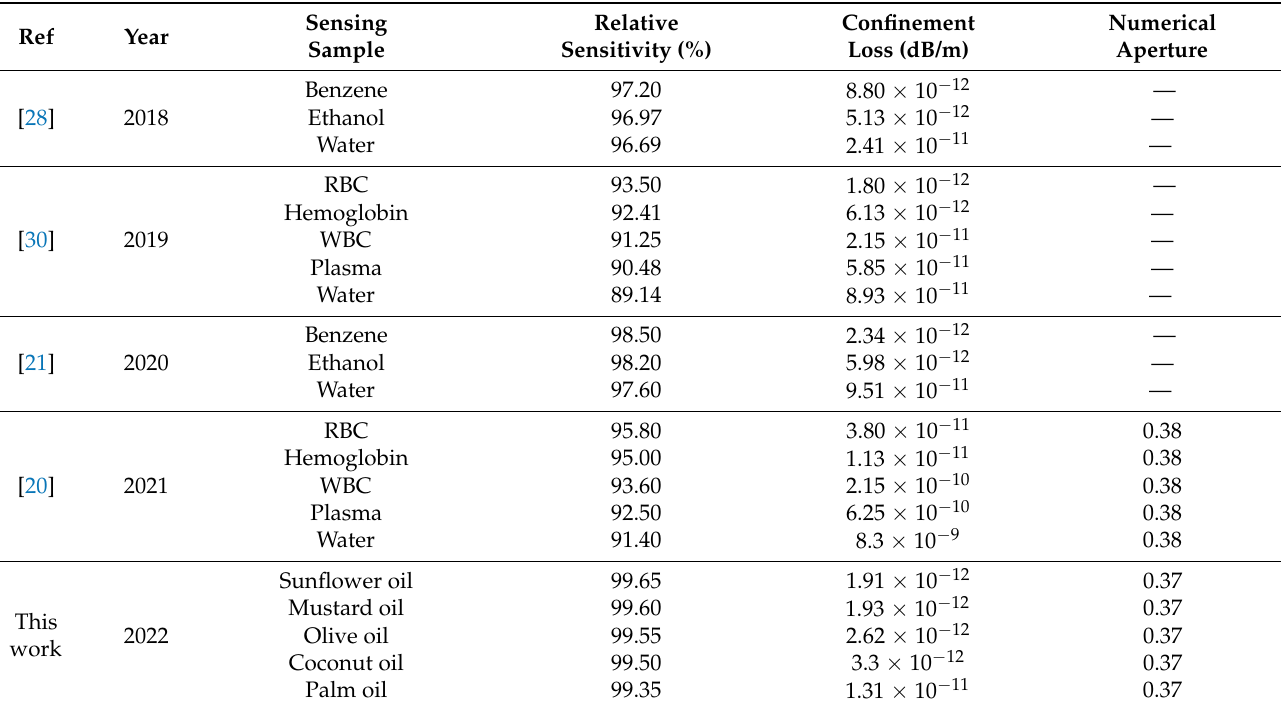
Table 2. Comparison of sensing and guiding characteristics of PCF-based